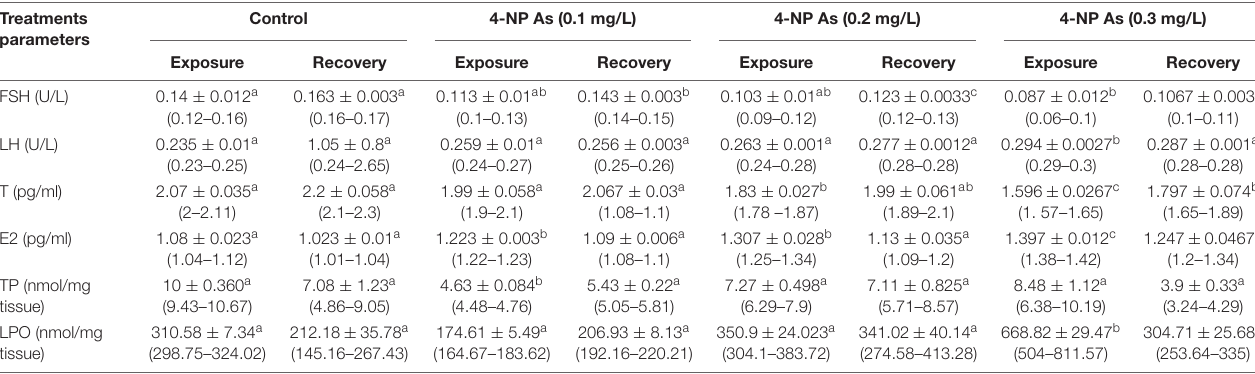
TABLE 1 | Effect of different doses of 4-non-ylphenol (4-NP) on hormones, total protein, and lipid peroxidation mean ± SE (range) in juvenile African catfish ( Clarias gariepinus ) exposed to 0.1, 0.2, and 0.3 mg/L4-NP for 15 days and recovery for 15 days. Treatments